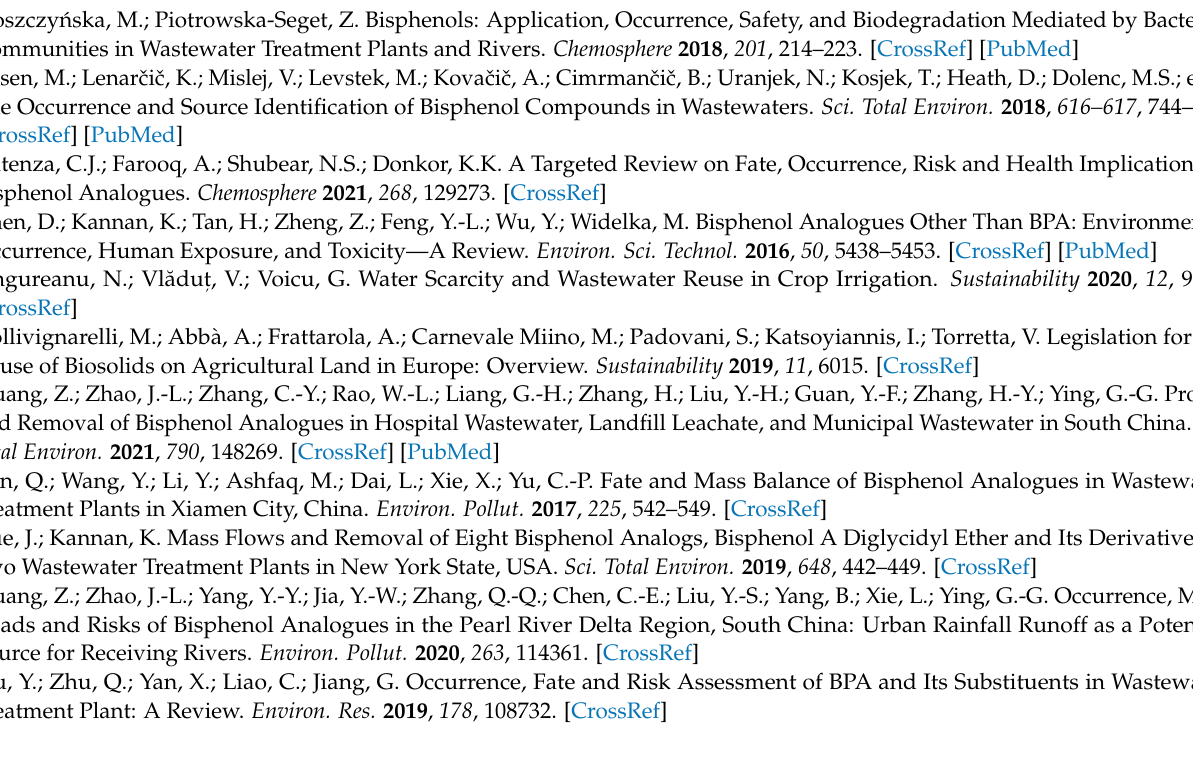
extraction procedures; Table S2: A list of bisphenols and internal standards, monitored ions [m/z] (quantifier ion in bold and two qualifier ions) of derivatised compounds, and retention times (RT); Table S3: Validation parameters (method repeatability, instrumental repeatability, accuracy, k and R2 values, SPE recovery, LOD and LOQ) of an analytical method for determination of 16 BPs in the solid phase of sludge; Table S4: Matrix effect; Table S5: Validation parameters (k and R2 values, recovery, LOD, LOQ) of an analytical method for the determination of 16 BPs in the aqueous phase of sludge and WW; Table S6: Concentrations of BPs in WW and sludge at different points and in different phases; Table S7: Sampling time, volumetric flows, total suspended solids, and other basic parameters in wastewater and sludge flows; Table S8: Total BPs mass flows and their distribution in different types of sludge in aqueous and solid phase; Table S9: Comparison of mean concentrations of BPs in influent, effluent, sludge and their removal with literature [7,9–11,16,17,27]. Author Contributions: Conceptualization, A.V. and A.K.; methodology, A.V., A.K. and D.Š.;